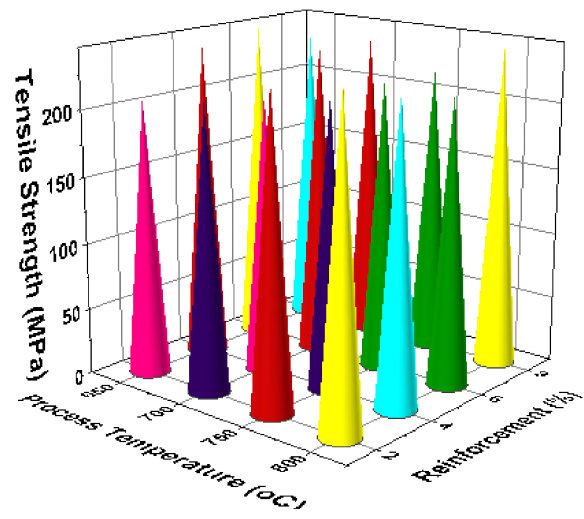
Figure 14. 3D bar plot: process temperature vs. reinforcement %.